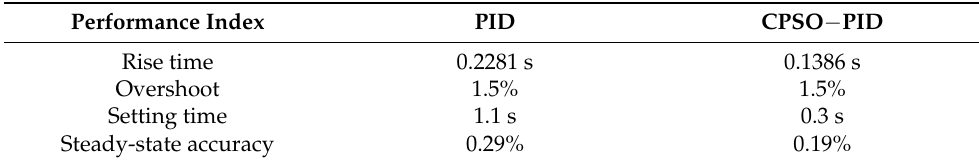
Table 2. Comparison of CPSO-PID and PID performance